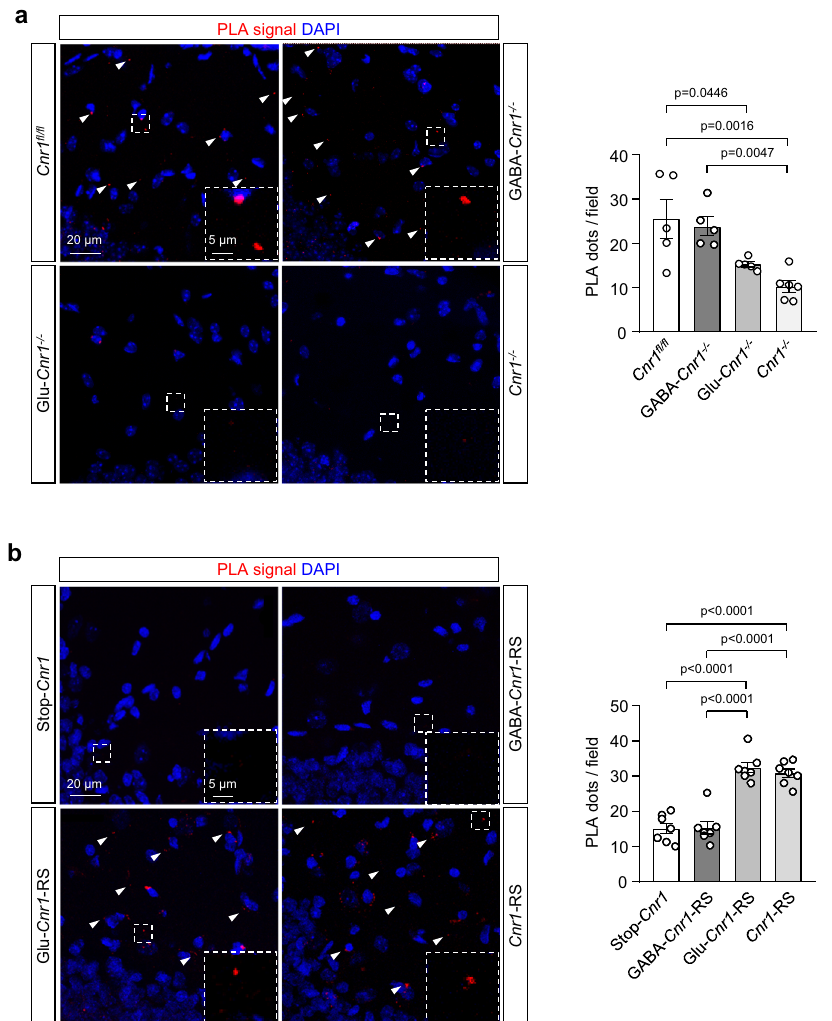
n =5 mice, GABA- Cnr1 − / − n =5 mice, Glu- Cnr1 − / − n =5 mice, Cnr1 − / − n =6 mice; one- way ANOVA with Tukey ’ s multiple comparisons test). b Representative images of DG-IML sections from Stop- Cnr1 , GABA- Cnr1 -RS, Glu- Cnr1 -RS, and Cnr1 -RS mice. Arrowheads point to some of the complexes. Inset magni fi cations are included for each genotype. Quanti fi cation of PLA-positive dots per fi eld is shown (right, means±SEM; n =7 mice per group; one-way ANOVA with Tukey ’ s multiple com- parisons test). Source data are provided as a Source data fi